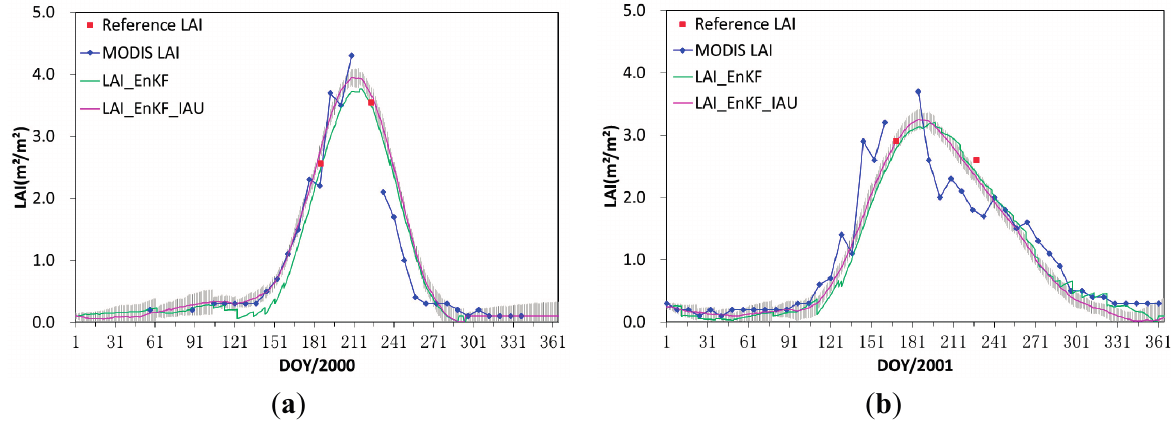
Figure 3. Retrieved LAI profiles by the inversion method with IAU at the center pixel of ( a ) the Bondville site in 2000 and ( b ) the Konza site in